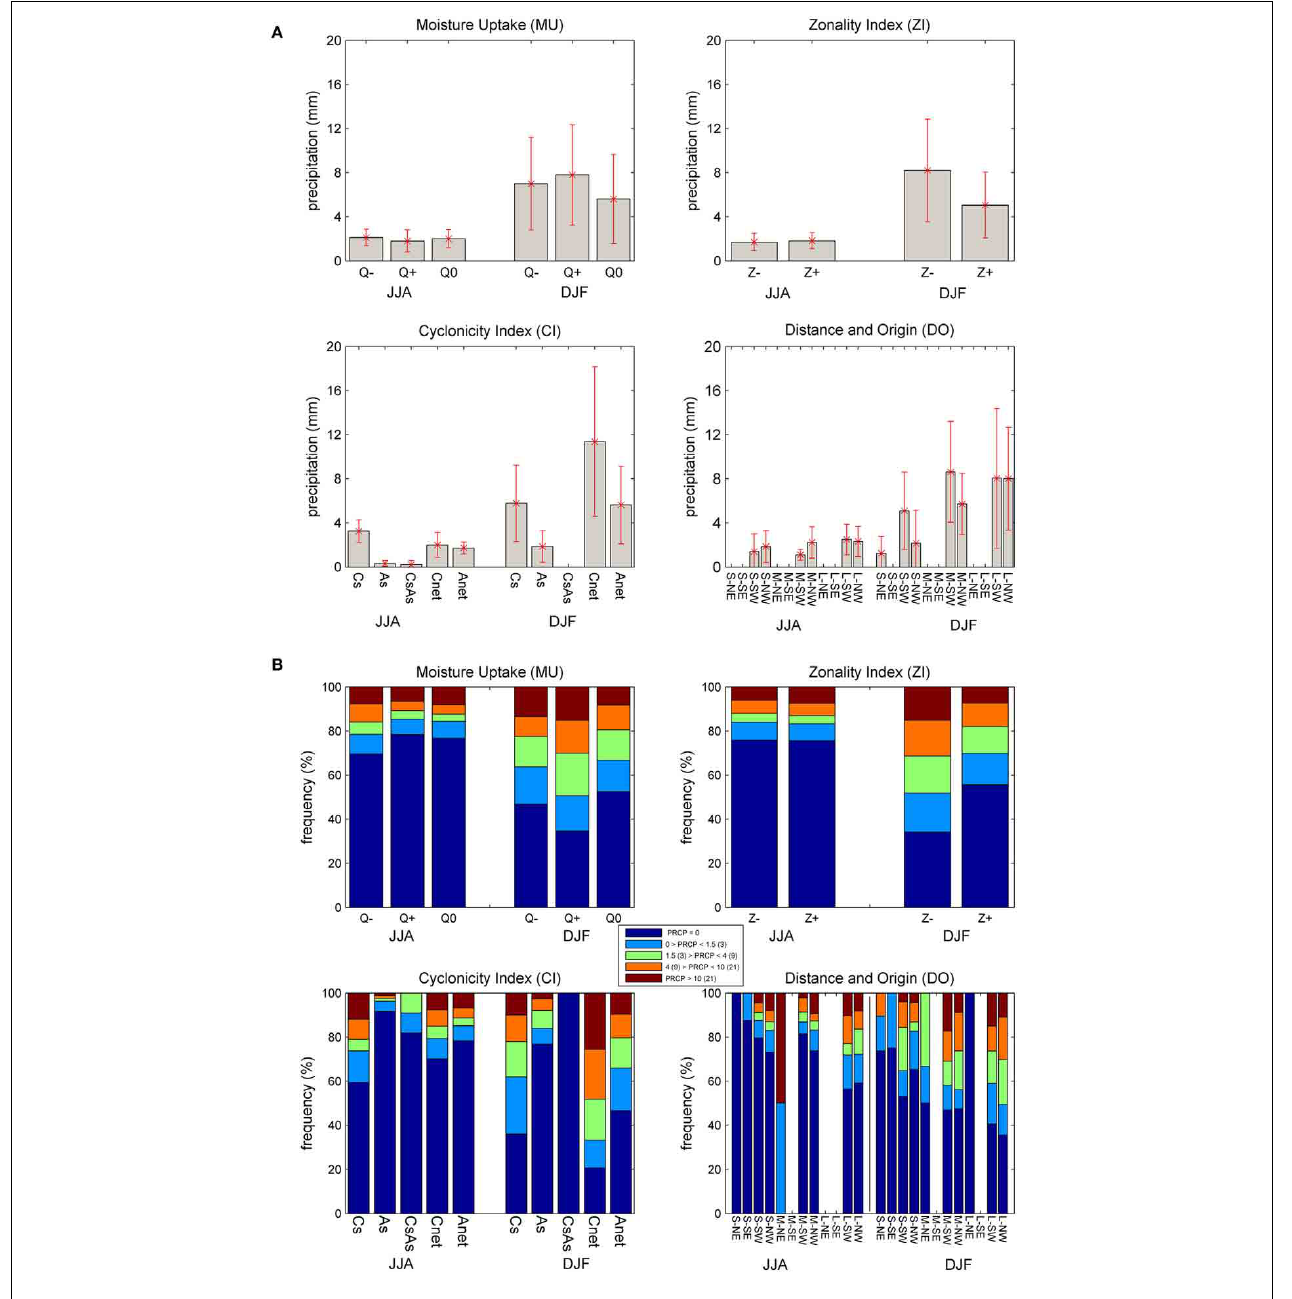
FIGURE 9 | (A) Seasonal average precipitation (mm) and the corresponding inter-annual variability (red lines) attributed to the Lagrangian classes; (B) Contribution of each Lagrangian type (in %) to five different categories of